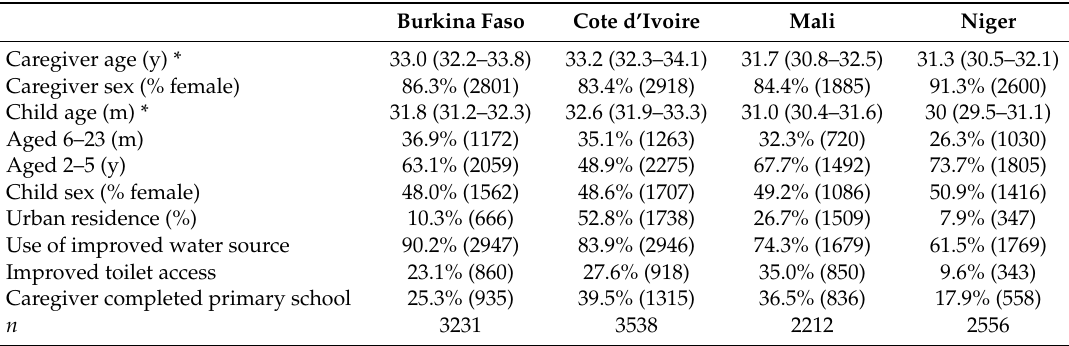
Table 2. Summary of respondents’